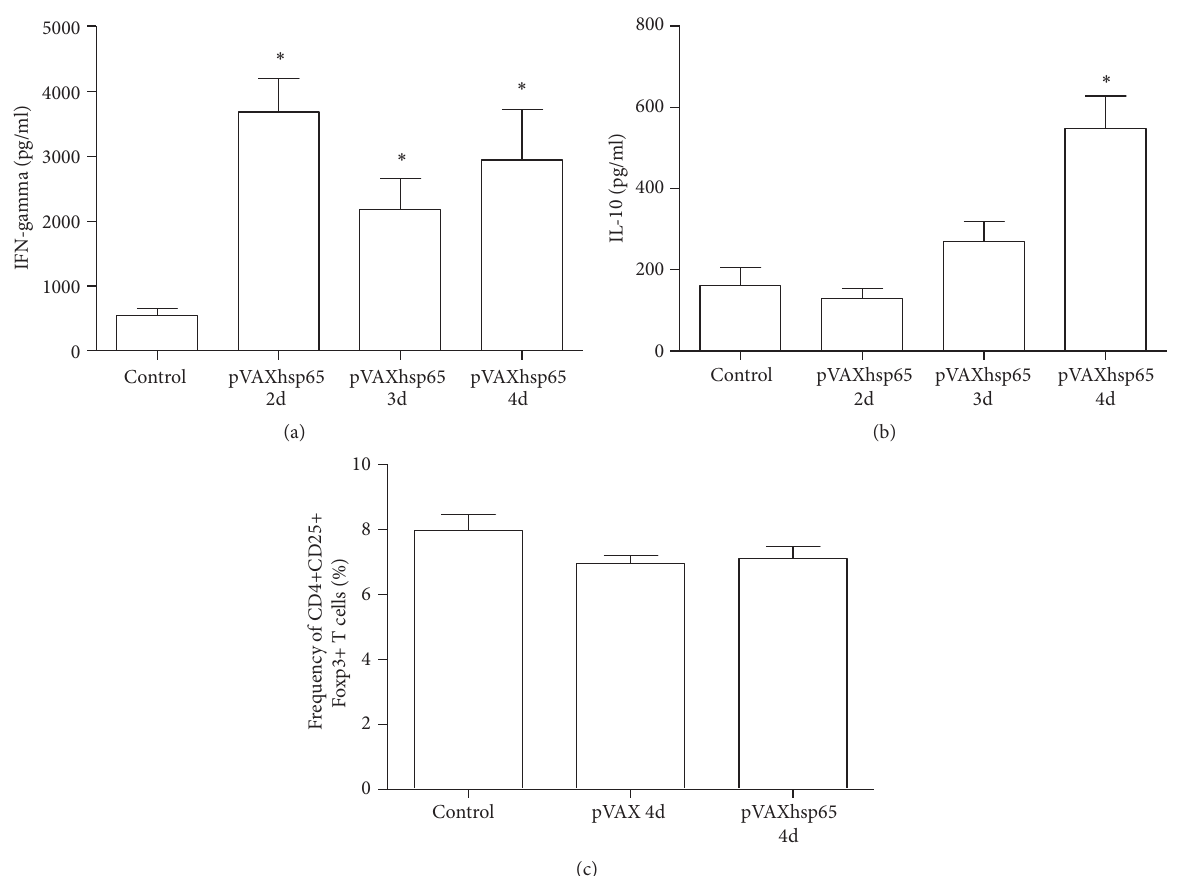
Figure 1: Immune response induced by pVAXhsp65 vaccination . C57BL/6 mice were immunized with 2, 3, or 4 pVAXhsp65 doses with 14 days’ interval. IFN- 𝛾 (a) and IL-10 (b) production were assessed in spleen cells cultures restimulated in vitro with rhsp65. The percentage of CD4+CD25+Foxp3+ T cells was evaluated in the total number of spleen cells 14 days after the last dose of pVAXhsp65 (c). Data were presented by mean ± SE of 6 mice and are representative of two independent experiments. ∗ represents the difference between immunized and control group. 𝑝 < 0.05